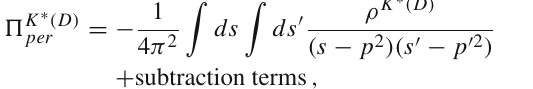
other coefficients are contributions of the non-perturbative ∗ ( D ) part ( (cid:14) K nonper ). It is important to note that in above equa- ρν ( 5 ) ¯ (cid:18)σ (cid:18) | 0 (cid:6) ≡ m 2 tion, C μ (cid:4) 0 | ρν T a G a Therefore, we can collect the coefficients C